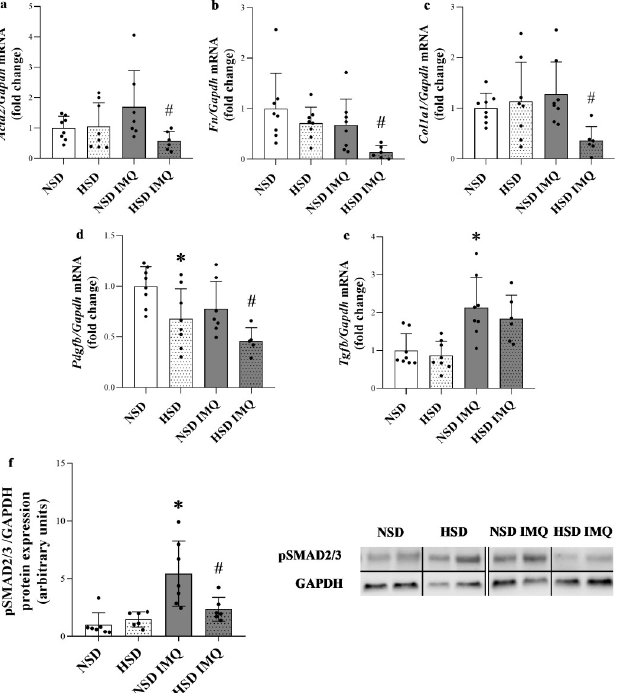
Fig 3. Effect of high salt diet on ECM marker production and dermal tissue remodeling-associated factors of IMQ-treated and control mice. ( a-e )The dermal mRNA expression of Acta2 , Fn , Col1a1 , Pdgfb and Tgfb in the skin tissues of mice was determined by real-time PCR in comparison with Gapdh . ( f ) The dermal protein expression of (p) SMAD2/3 in the skin tissues of mice was determined by Western blot in comparison with GAPDH as protein loading control. Protein samples from control and IMQ-treated mice were run on separate gels. They were compared based on internal control. Full-length blots are included in Supporting Information . Data were normalized and presented as the ratio of the mean values of the control group. Values were expressed as mean+SD. Dots represent individual values. n = 6–8 in each group; � p < 0.05 vs. NSD; # p < 0.05 vs. NSD IMQ; (Unpaired t-test (a,b,d), Mann-Whitney U-test